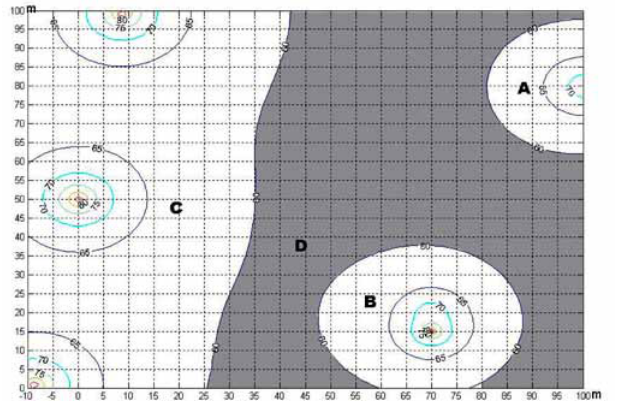
Fig. 9. SPL distribution (dB) in the hypothetic